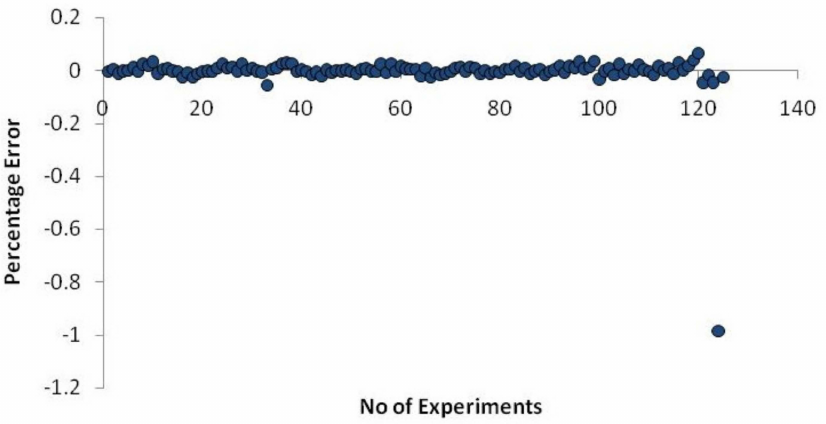
Figure 25. Error graph of network 4-9-3 for angular distortion with time gap between four passes. The error percentage of angular distortion varied from − 0.7% to +0.1%, − 1% to +0.4%, and − 0.9% to +0.1% for time gaps between two, three, and four passes, respectively, as shown in the